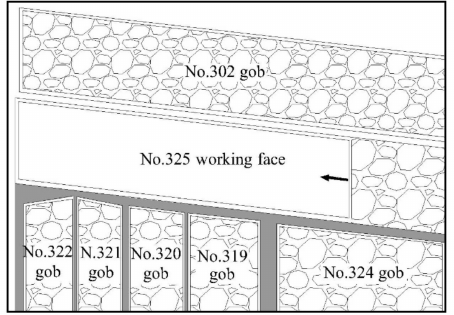
Figure 1. Distribution map of goaf around panel No. 325.